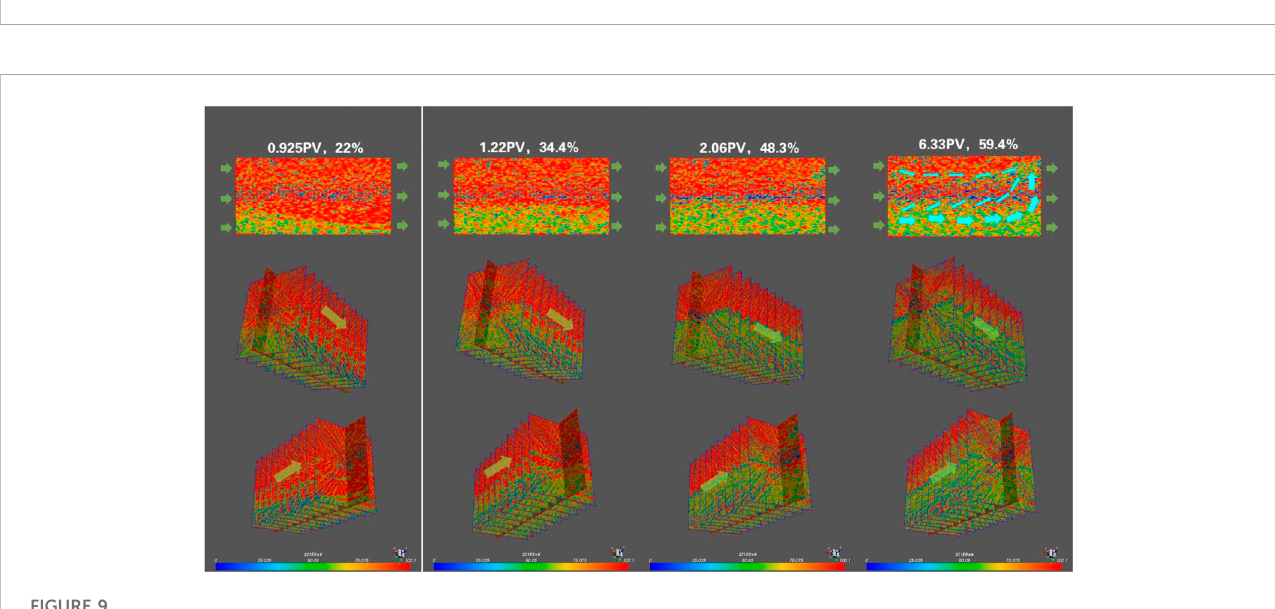
FIGURE 9 Oil saturation distribution in SZ1